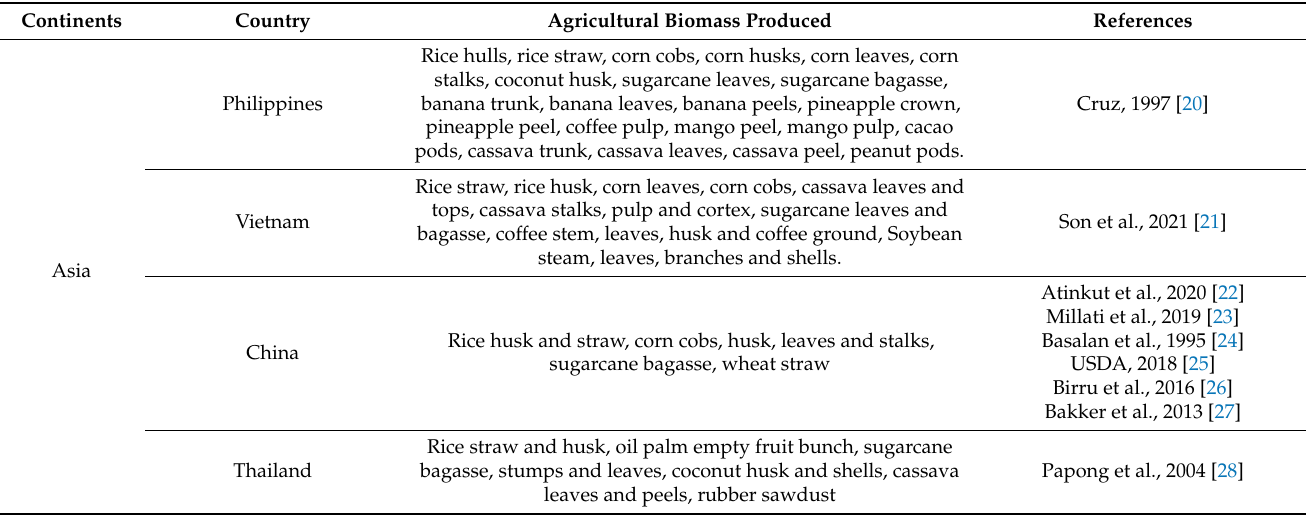
Table 1. Agricultural biomass produced in selected countries of the